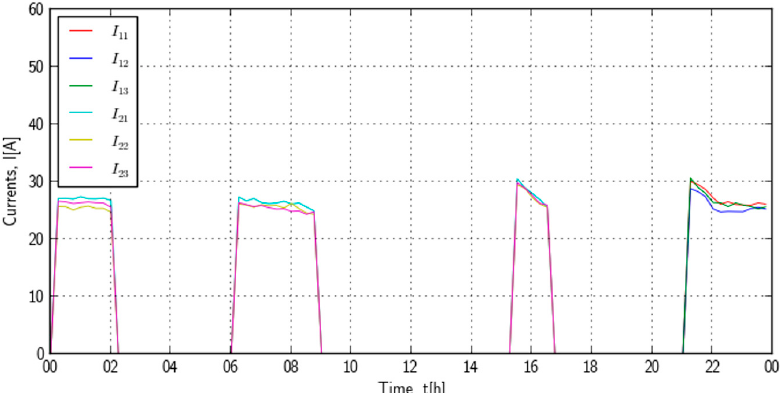
Figure 22. The diagrams of the load current changes of PU2 and PU1 recorded on 25 June 2009. (Sampling period of 15 min) .